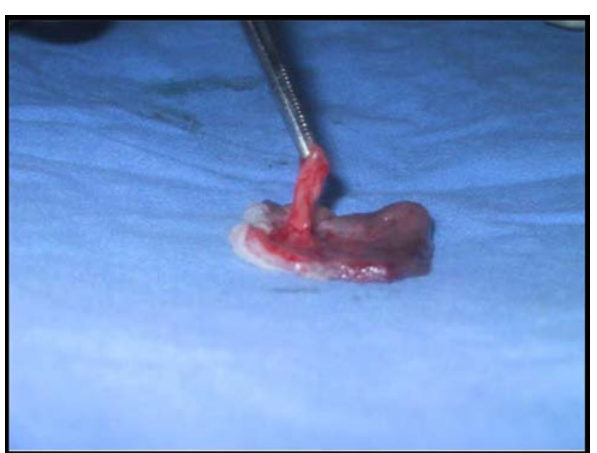
FIGURE 3 - Aspect of the resected abdominal wall, including 1.0cm of adhesions, before dying